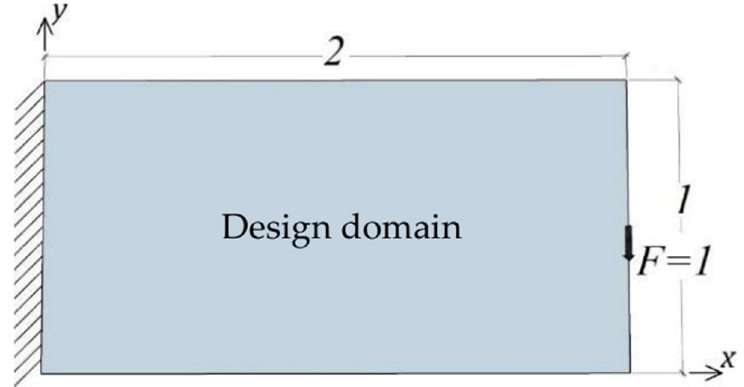
Figure 3. Problem definition of the cantilever plate (case 1): design domain, loading, and support.